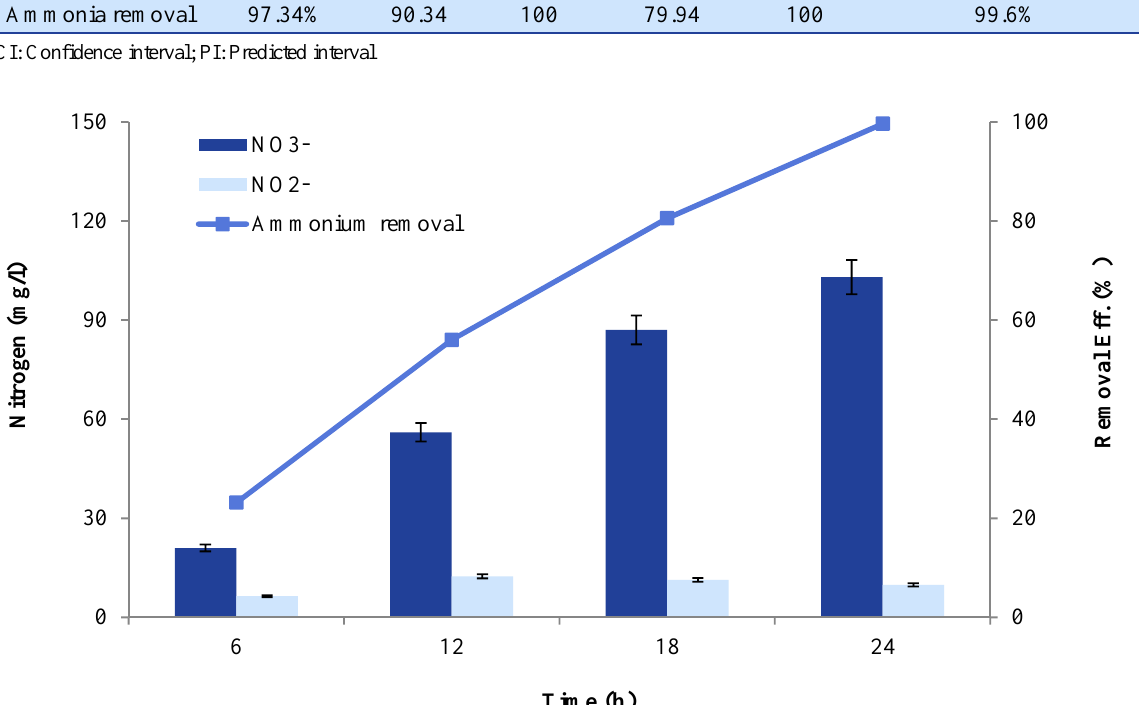
Figure 7. Variation of nitrogenous compounds during ammonia